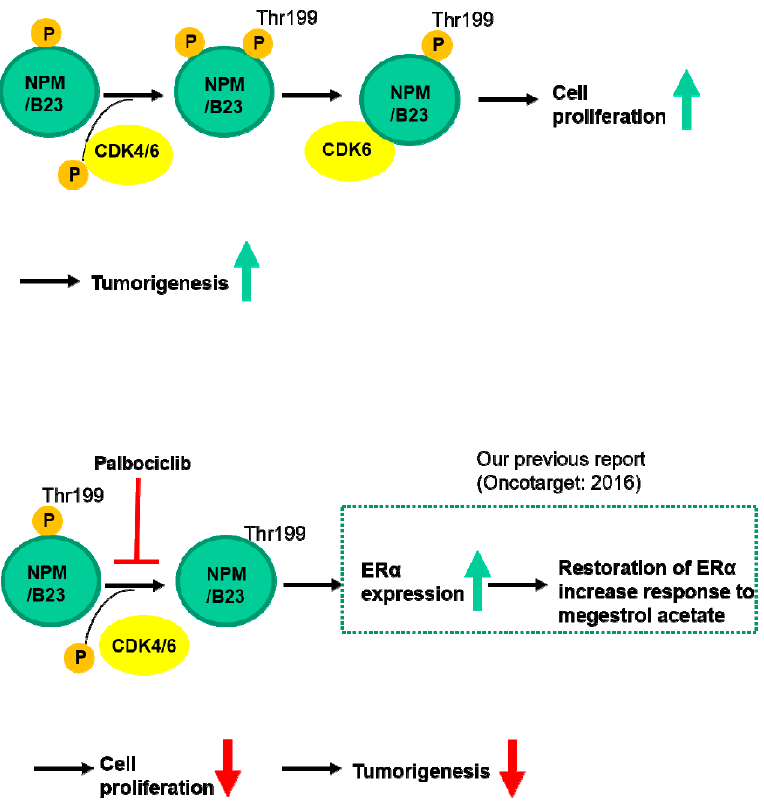
Figure 7. Schematic representation of the inhibitory effects of palbociclib on endometrial cancer cell growth. Palbociclib is capable of inhibiting phosphorylation of NPM / B23 (Thr199) and promoting ER α expression, ultimately sensitizing hormone-refractory endometrial cancers to endocrine therapy.